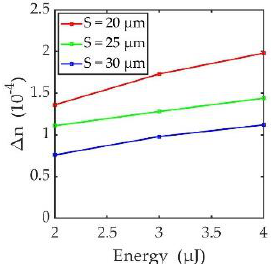
Figure 8. Refractive index contrast as a function of pulse energy; the scanning speed is 100 µ m / s for all